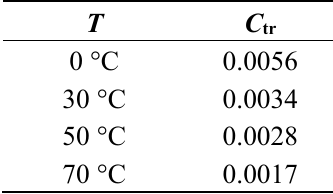
Figure 2 . Inverse of the degree of polymerization as a function of the CTA to premonomer concentration ratio for MDMO-PPV synthesized via the sulfinyl “precursor” route at different polymerization temperatures. Table 3 . Chain transfer constants determined from the plots given in Figure 2 for conjugated MDMO-PPV synthesized via the sulfinyl “precursor” route at different polymerization